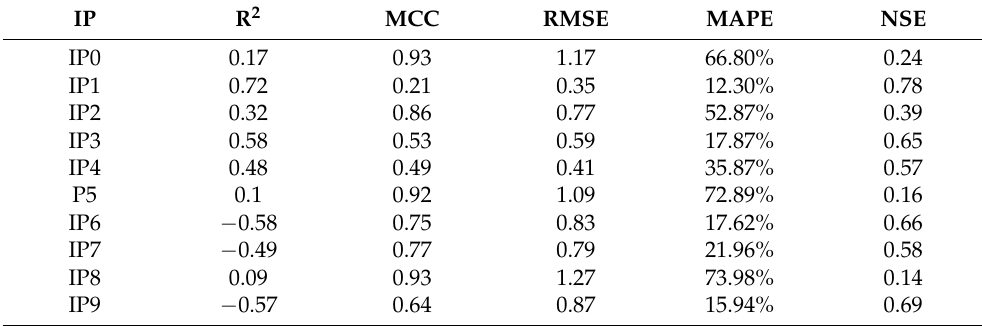
Table 3. Performance evaluation of developed DBoTPM model for botnet prediction based on different accuracy